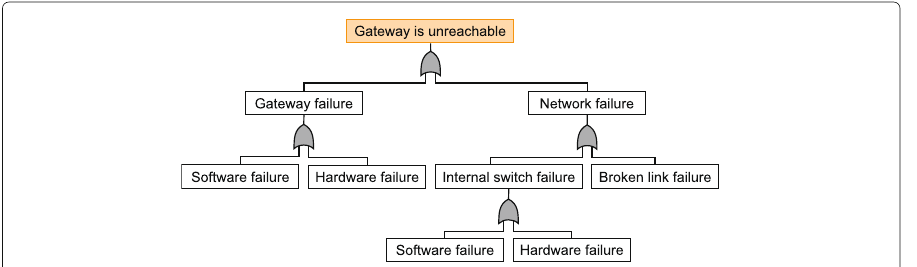
Fig. 2 This fault tree shows link disconnection errors, which need to be handled by the gateway redundancy